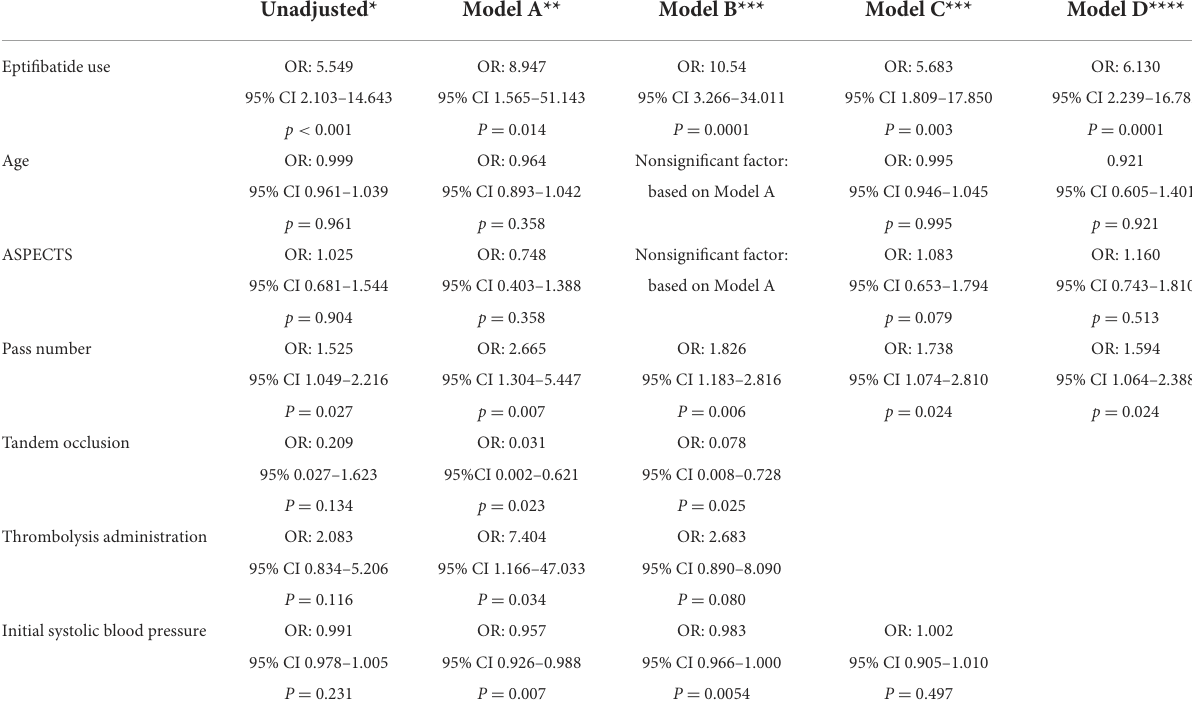
TABLE 4 Univariate and multivariable models for independent predictors of PH-1 and PH-2 after mechanical thrombectomy. Unadjusted* Model A** Model